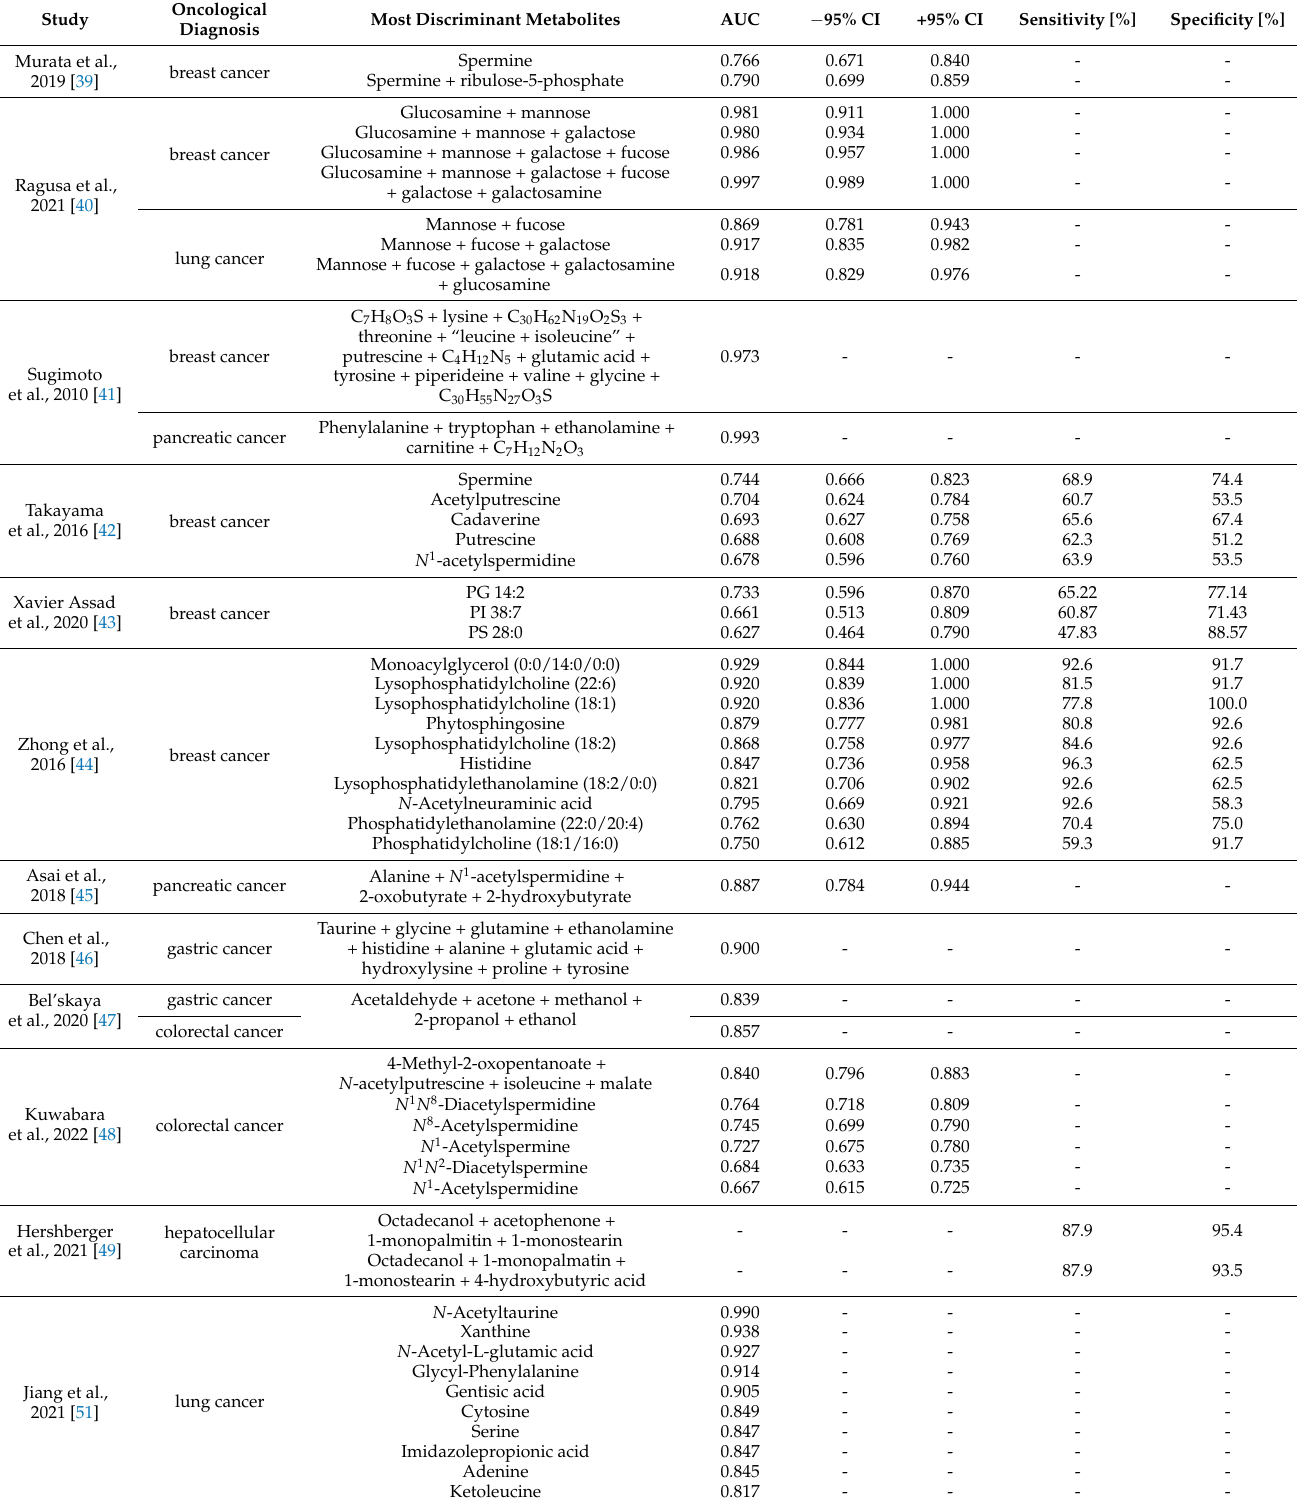
Table 4. Determined predictive parameters for most discriminant metabolites from included